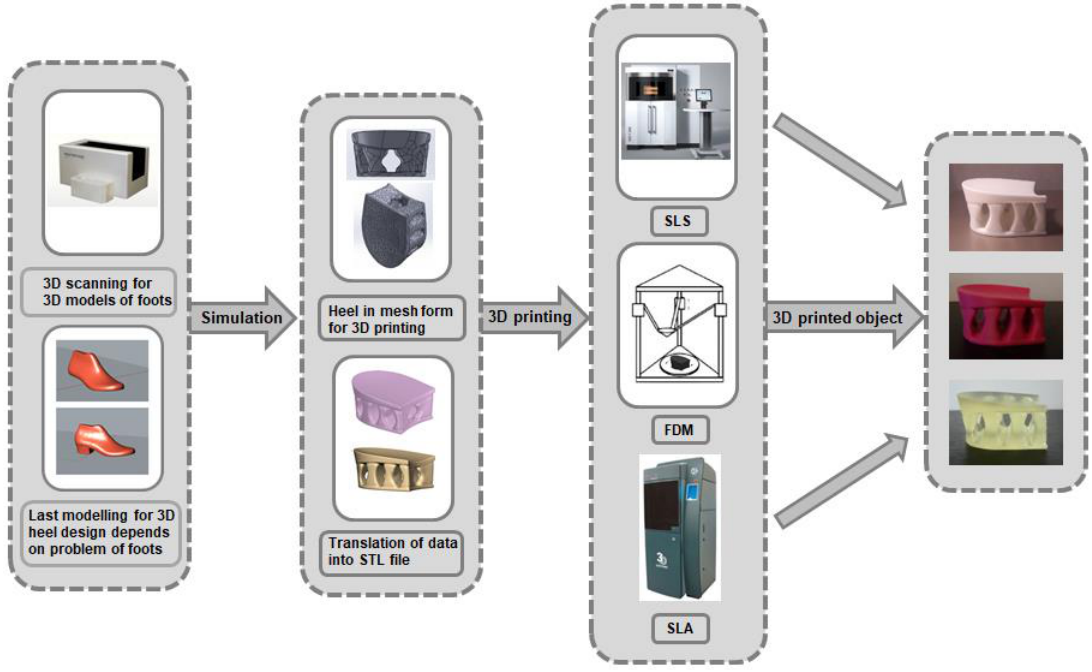
Figure 2. Modern digital technologies in the manufacturing of orthopedic footwear.